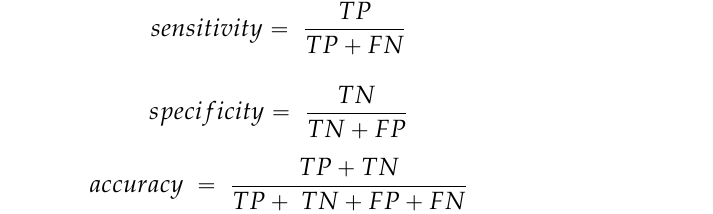
Figure 19. The effect of aging over the eye region.